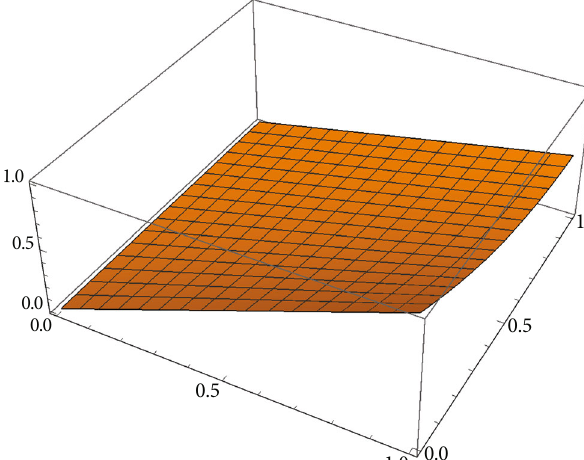
Figure 10: Exact solution for Example 8.